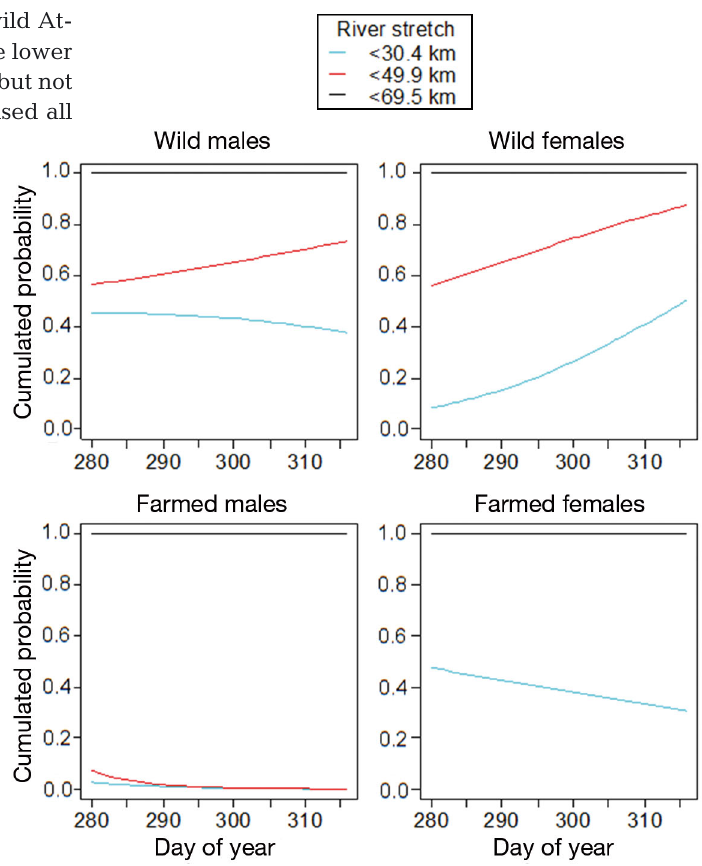
Fig. 5. Predicted probability of use of river stretches (zones) by Atlantic salmon Salmo salar during the spawning period as function of origin, sex and day of year. N = 11 wild females, 8 wild males, 5 farmed females, and 7 farmed males. Individuals of unknown sex were